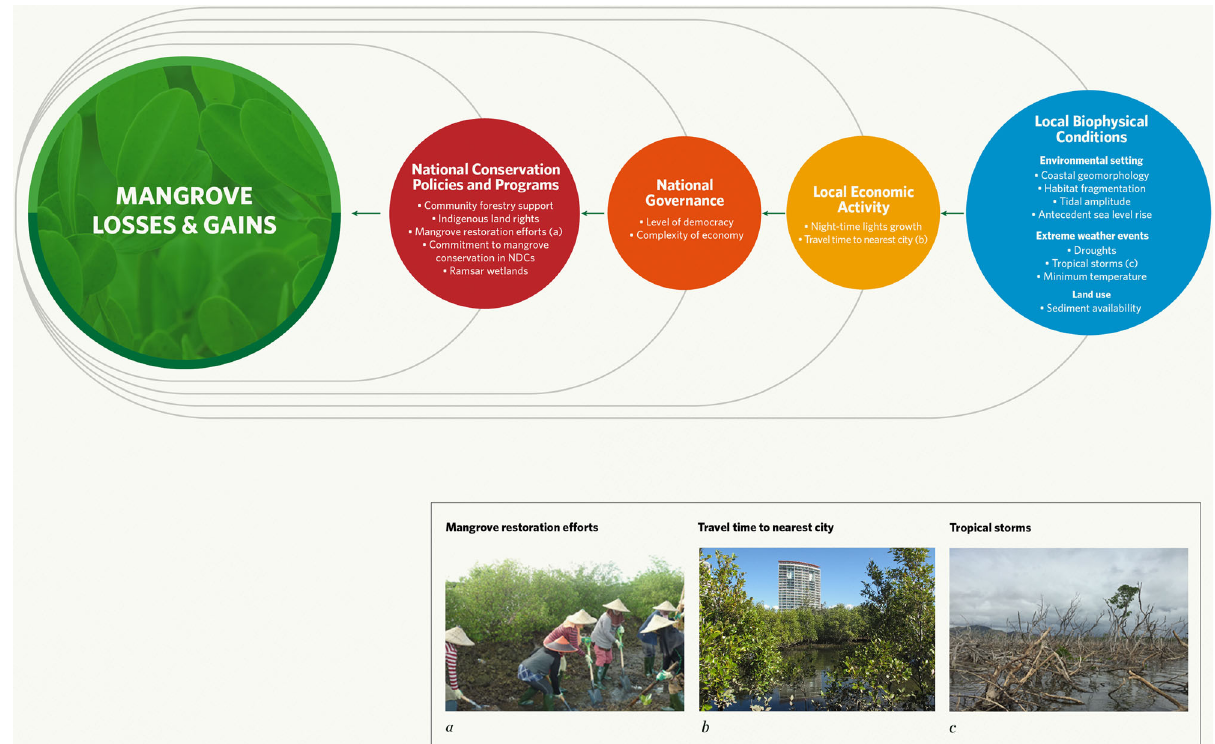
Fig. 1 | Factors that in fl uence global mangrove cover losses and gains